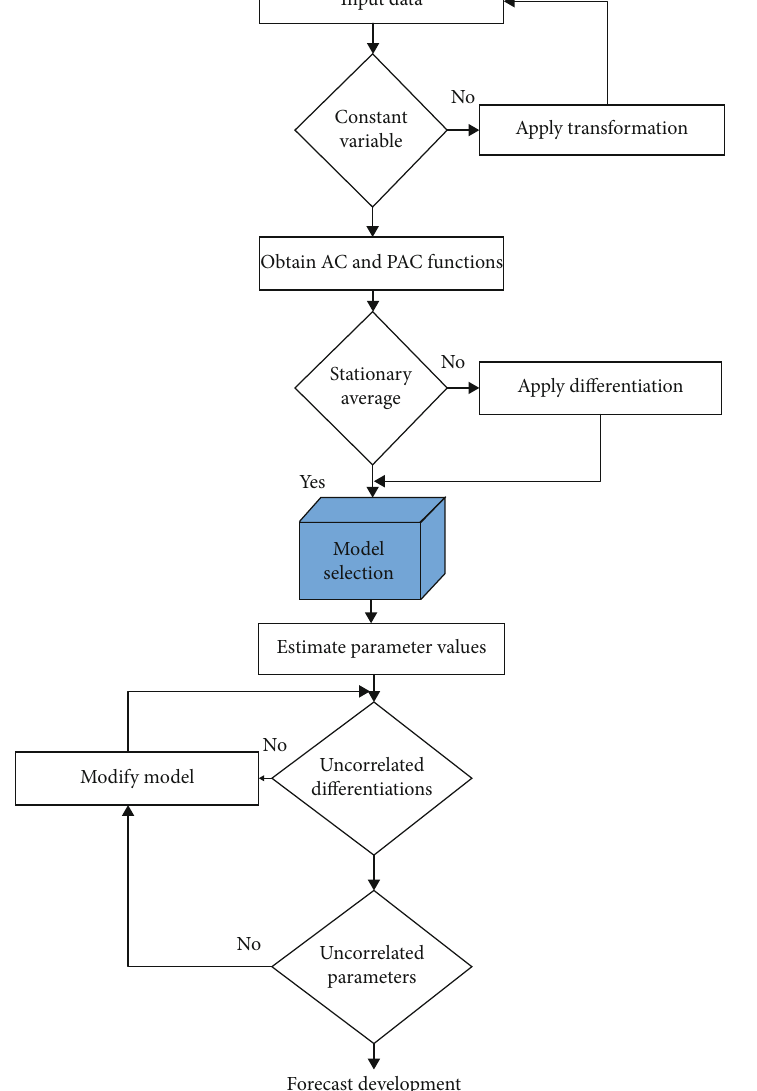
Figure 1: Operation of the ARIMA model for the energy production forecast of a photovoltaic system; AC and PAC autocorrelation functions are